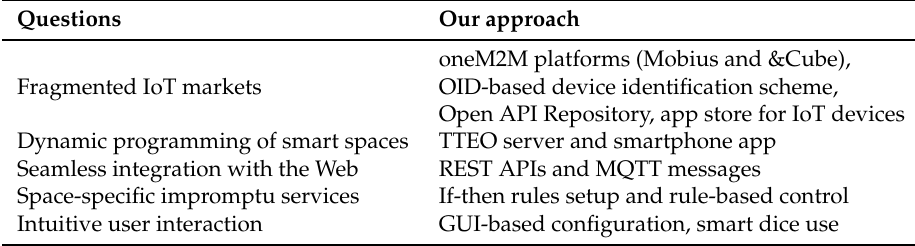
Table 1. Summary of research questions on building smart spaces and our approach.